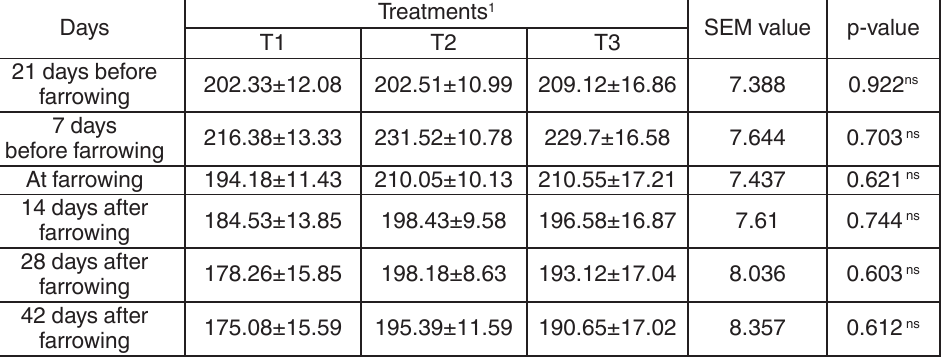
table 3. Fortnightly average body weight of sows maintained on three experimental rations, kg Days